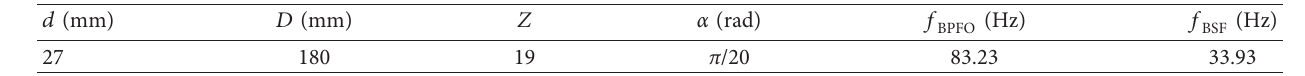
Figure 18: Photos of defects. (a) Three artificial outer race defects and (b) an artificial roller defect. Table 2: The structural parameters and fault characteristic frequencies of